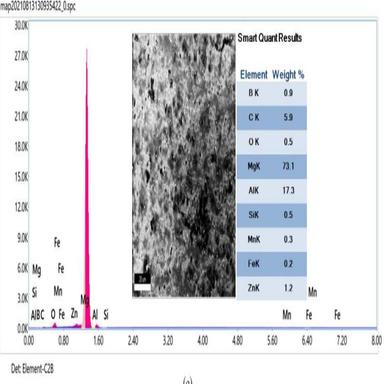
EDX Analysis (a) AZ31 alloy, b) AZ31-1.0 B4C, C) AZ31-2.0 B4C.